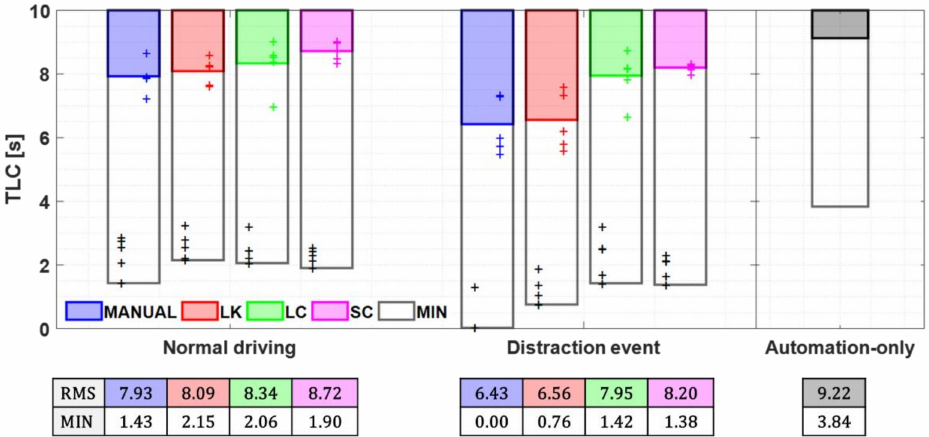
Figure 11. Safety indicators statistics (RMS and MIN of